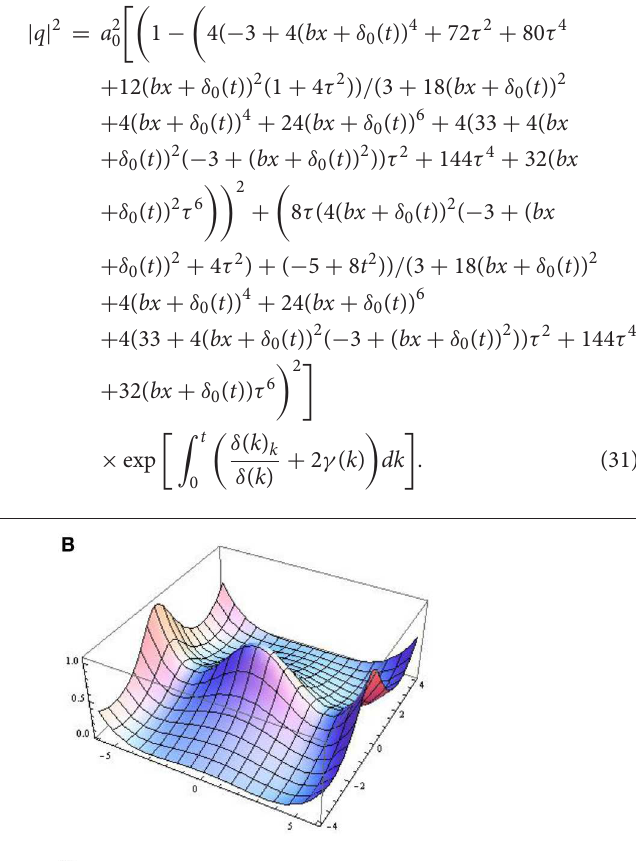
0.1, (C) δ ( t ) 0.7 and = = 0.35 t 2 , and (F) δ ( t ) 0.1 1.2cos(0.1 t ) = = +